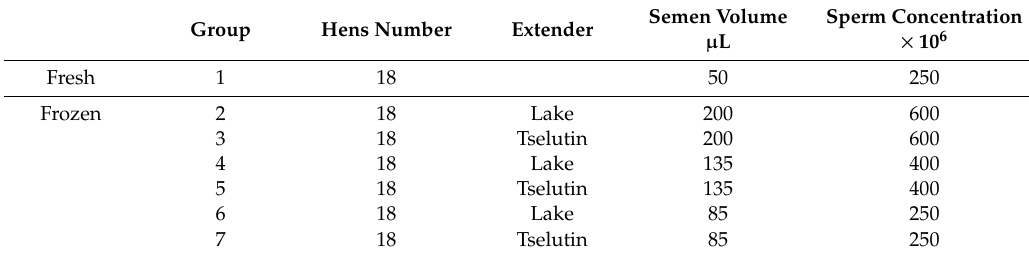
Table 2. Experimental groups of turkey hens used in the artificial insemination